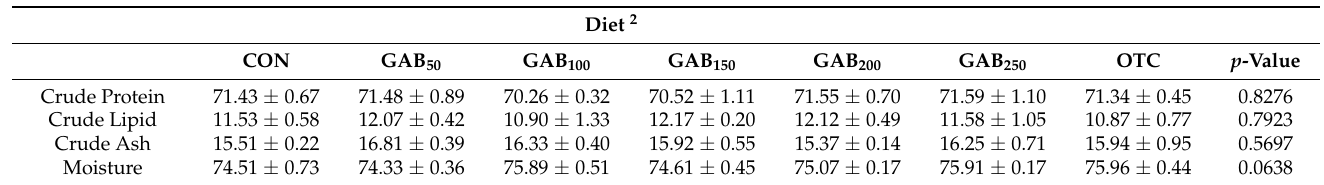
Table 3. Proximate composition (DM) % of juvenile olive flounder fed experimental diets 1